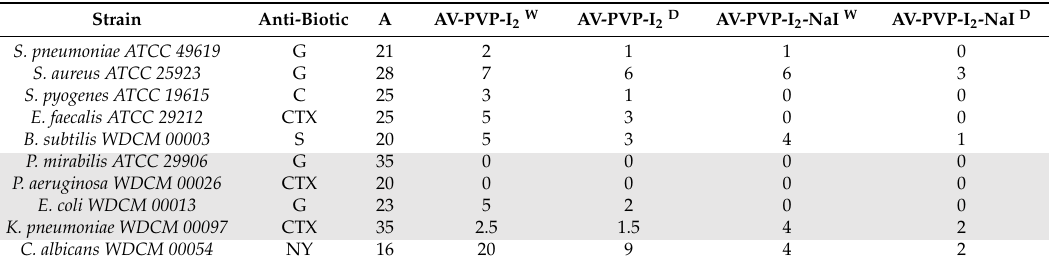
Table 2. Antimicrobial activity of selected antibiotics (A), AV-PVP-I 2 , AV-PVP-I 2 -NaI and their dip-coated sutures (W = 30 min after coating procedure, D = after 3 h drying). ZOI (mm) against selected microorganisms by di ff usion assay.